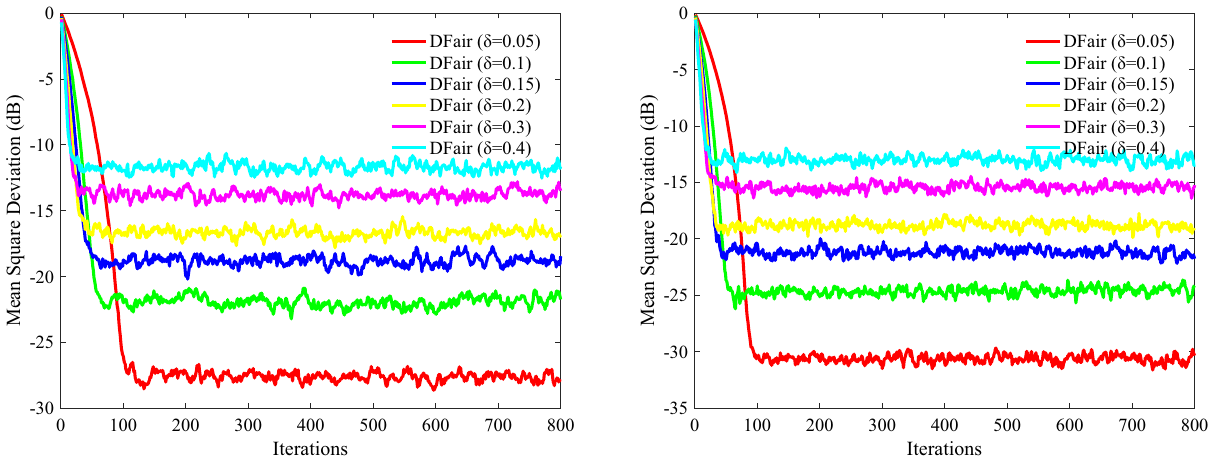
Figure 4. MSD curve with different δ of the DFair algorithm ( μ = 0.4) when network topology and neighbors to be decided by closeness in the distance (radius = 0.3): (Left) R xx , n is a diagonal matrix with possibly different diagonal entries chosen randomly, Pr = 0.4, and σ 2 f = 0.2 . (Right) R xx , n = σ 2 x , n ( i ) I M , i = 1, 2, 3, . . . , M , Pr = 0.4, and σ 2 f = 0.4